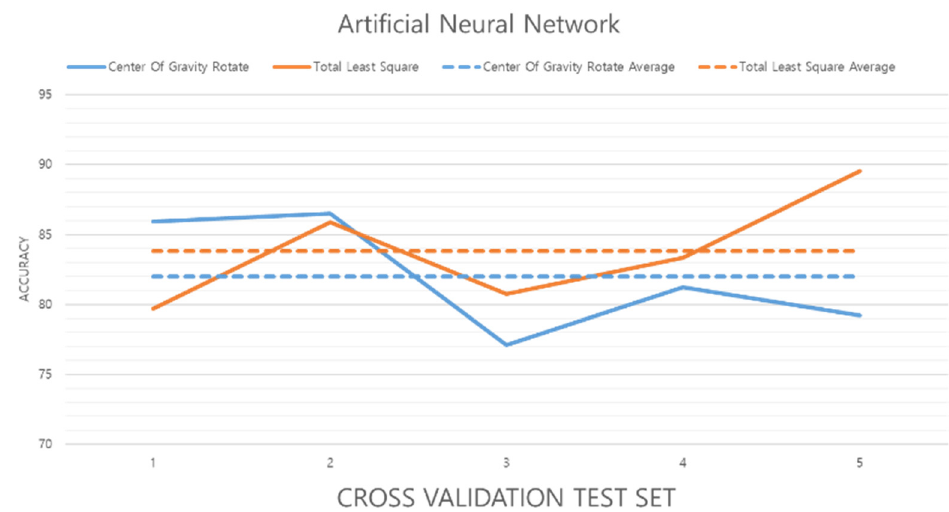
Figure 22. Performance evaluation of the chosen ANN algorithm.